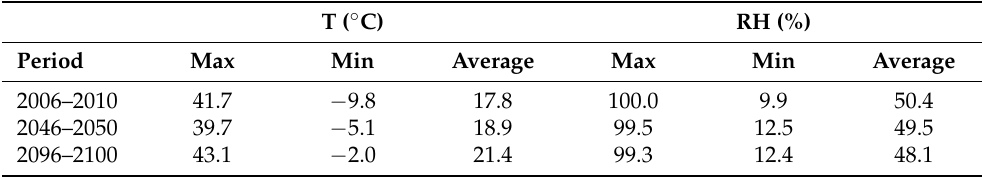
Table 1. Meteorological parameters of the used